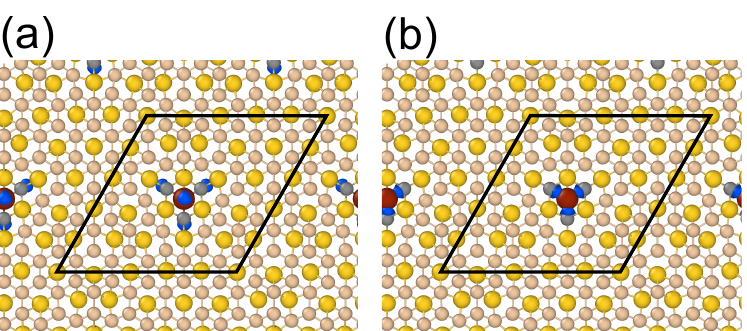
Figure 3. Spin density distribution of Fe-doped silicene/Au structure at concentration of Fe atoms N = 2%. Blue isosurfaces represent positive ( a ) and negative ( b ) spin densities equal to 10 − 6 e/Å 3 ,